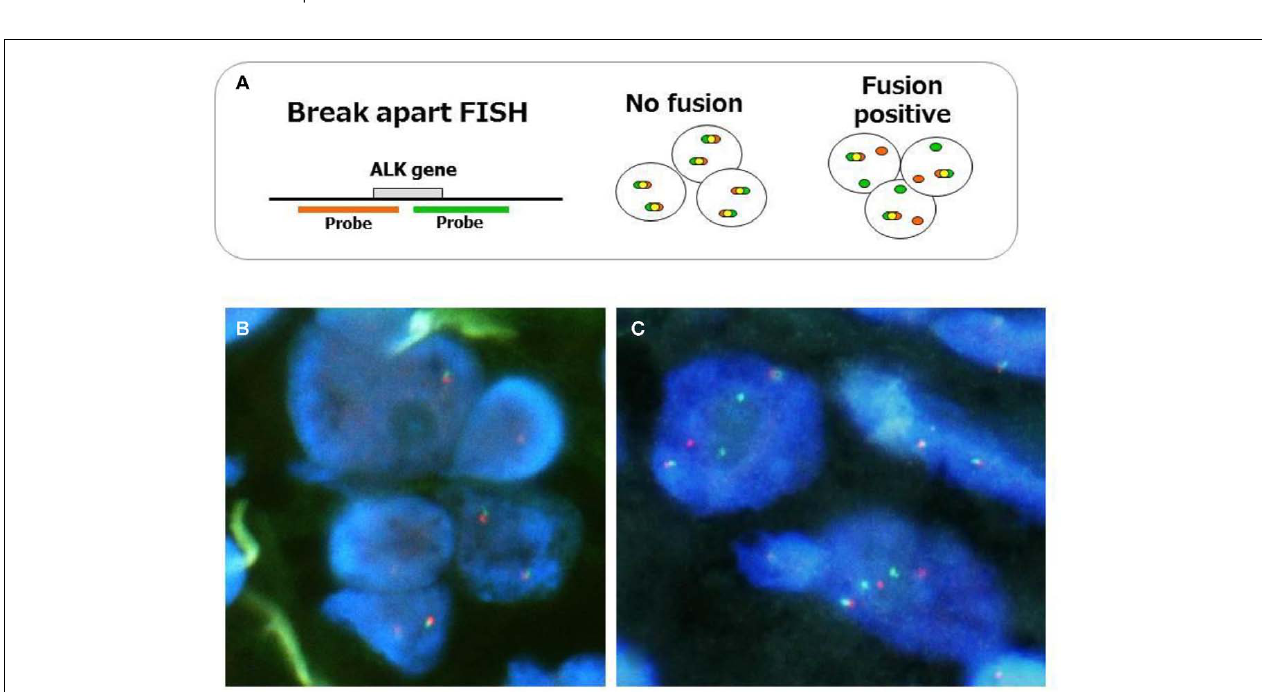
signals are two or more signal diameters apart. (ii)There is a single orange signal without a corresponding green signal in addition to fused and/or broken apart signals.The tumor is considered positive ALK test when: (i) A sample is considered negative if < 5 cells out of 50 ( < 5/50 or < 10%) are positive. (ii) A sample is considered positive if > 25 cells out of 50 ( > 25/50 or > 50%) are positive. (iii) A sample is considered equivocal, if 5–25 cells (10–50%) are positive. If the sample is equivocal, a second reader should evaluate the